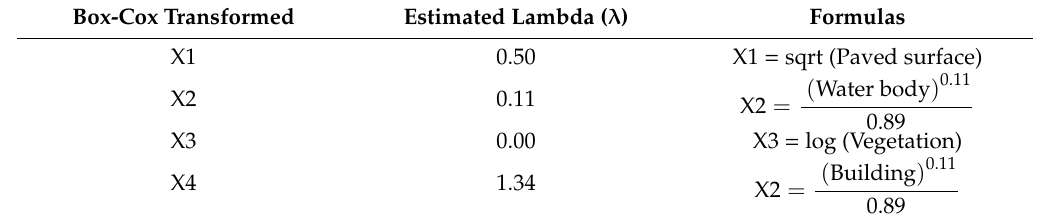
Table A2. Estimations of the lambda ( λ ) and